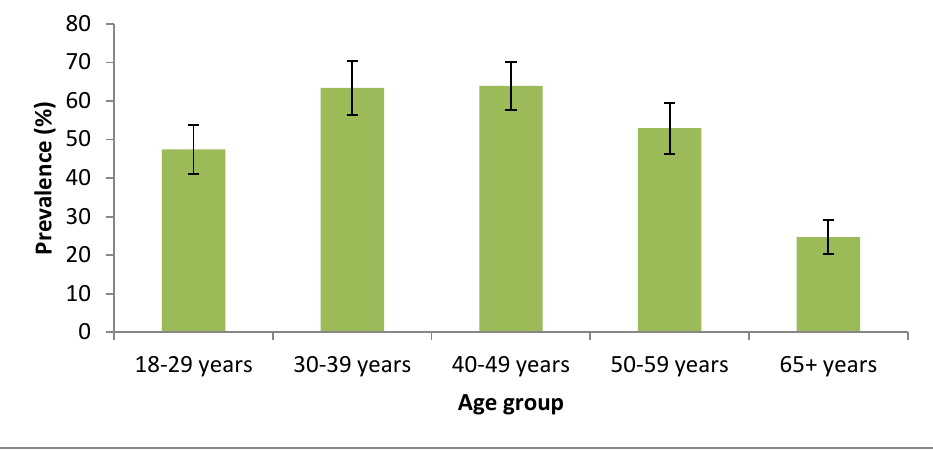
Figure 1. Prevalence of current smoking (with 95% error bars), by age group (men only, N = 1,248).